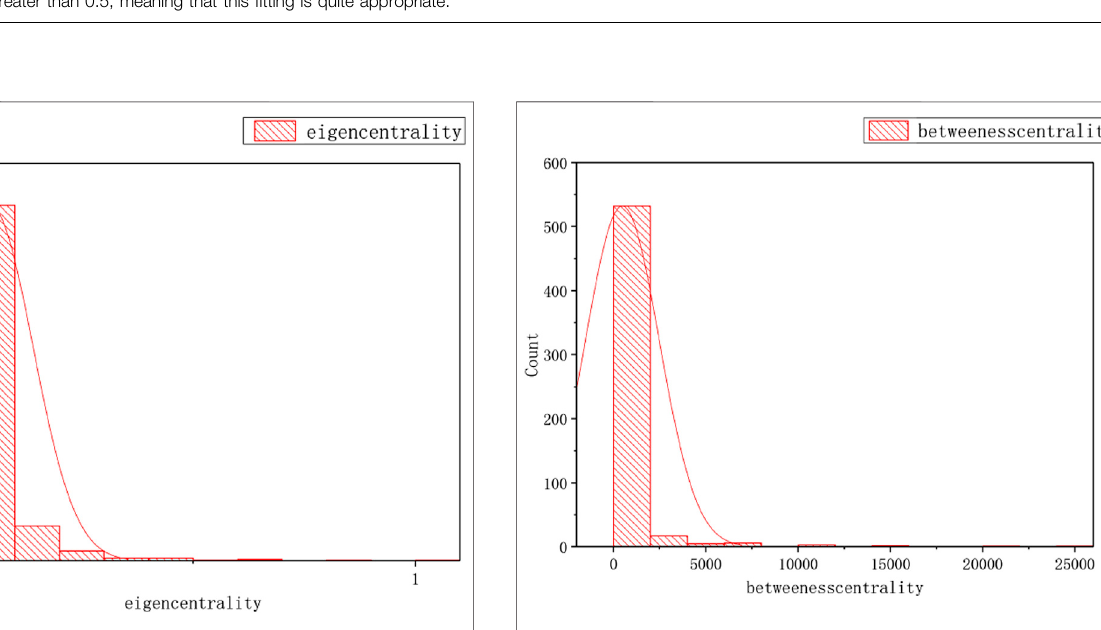
FIGURE 7 | The distribution of eigencentrality and RangeRank of the TOA Network: Plot the number of the number of eigencentrality on the vertical Y -axis against eigencentrality on the horizontal x